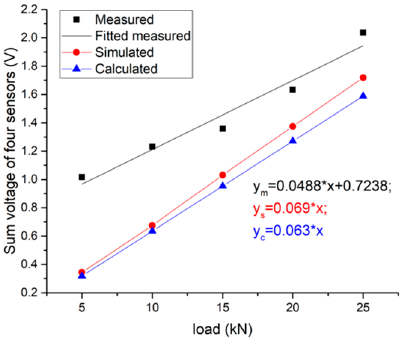
Figure 20. Comparison of measured, simulated and calculated values of total system output at 10 Hz loading frequency.